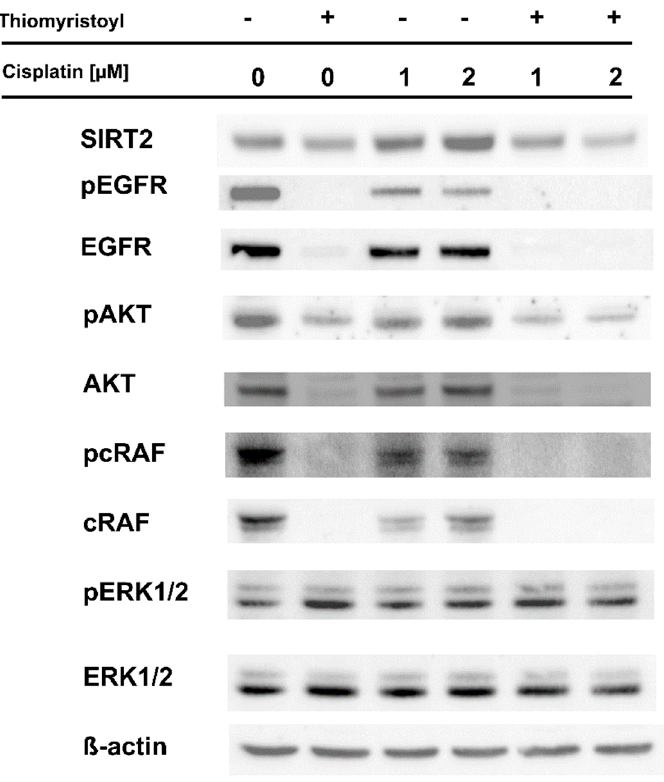
Figure 4. SIRT2 pharmacological inhibition impairs the response of melanoma cells to cisplatin. Control A375 cells and those pretreated with thiomyristoyl were treated with selected concentrations of cisplatin for 48 h. Then, protein lysates were prepared and analyzed by Western blotting.